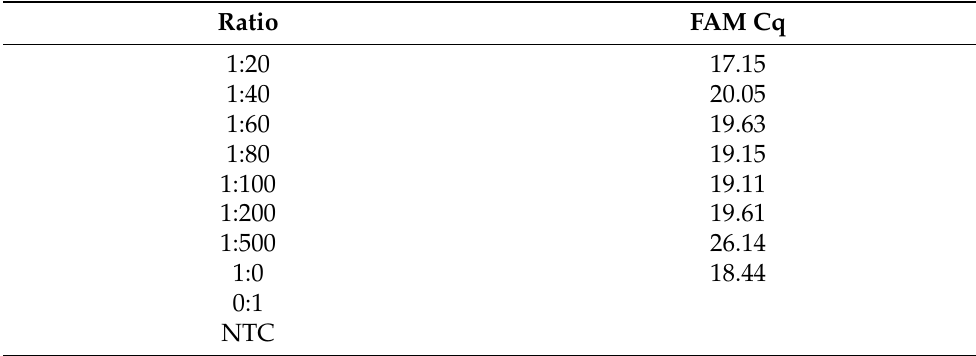
Table 4. Real-time PCR results from varying ratios of H. armigera legs: H. zea legs. The rcf ( × g) was 8609, the NaCl concentration was 100 mM, and the EDTA concentration was 5 mM for all ratios. The H. armigera probe was FAM